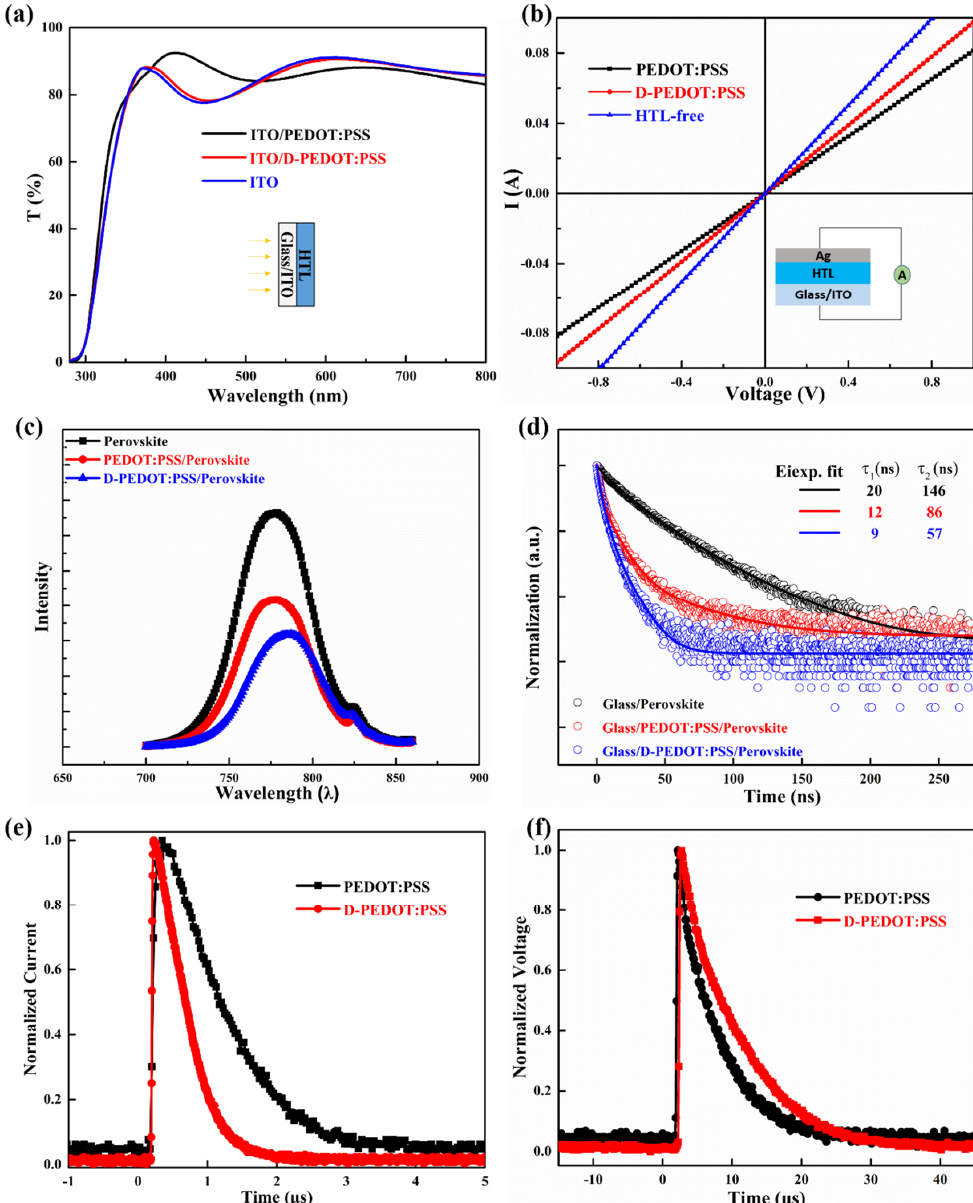
Figure 4. Optical and electrical performance of perovskite films on different HTLs: ( a ) transmittance; ( b ) conductivity; ( c ) PL spectra; ( d ) TRPL spectra; ( e ) TPV; ( f ) TPC. To further verify above conjecture, the photoluminescence (PL) and time-resolved photoluminescence (TRPL) techniques were employed to study the charge extraction and transmission [28,29]. Figure 4c shows the PL spectra of Glass/Perovskite, Glass/PEDOT:PSS/Perovskite and Glass/D-PEDOT:PSS/Perovskite. Among them, the PL peak intensity of Glass/Perovskite substrate is strongest. With no charge transport layer, the generated electron–hole pairs can only be quenched by competition between radia- tive recombination and non-radiative recombination. When the perovskite film is depos- ited on the HTL substrate, the lower peak intensity indicates that the hole is extracted more efficiently at the D-PEDOT:PSS/Perovskite interface, rather than emitting light in the form of radiative recombination in perovskite film with electrons. The PL results mean that PEDOT:PSS is a good hole transport material for hole extraction and the